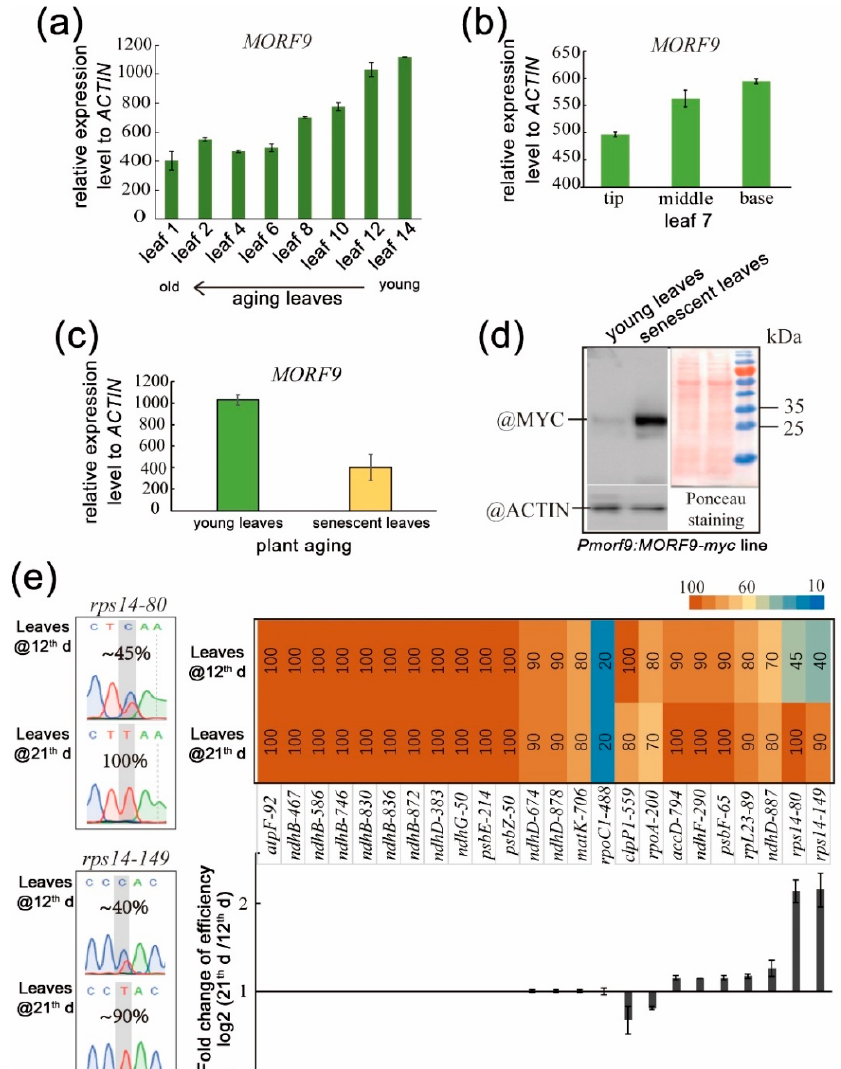
Figure 7. Alteration of MORF9 -associated RNA editing e ffi ciency during leaf senescence in WT Arabidopsis . ( a ) MORF9 mRNA levels of subsequent rosette leaves of mature plants; ( b ) MORF9 mRNA levels of leaf 7; ( c ). MORF9 mRNA levels of rosette leaves of young and aging plants; ( d ). Western blot of MORF9-MYC fusion protein in rosettes of plants expressing the tagged MORF9 driven by the native promoter. The Ponceau staining of the same membrane and Western blotting of ACTIN by anti-ACTIN antibody were used to control gel loading; ( e ) Plastid RNA editing e ffi ciency in leaves of 12-day-old and 21-day-old plants. Full dataset are provided in Supplemental Table S2.